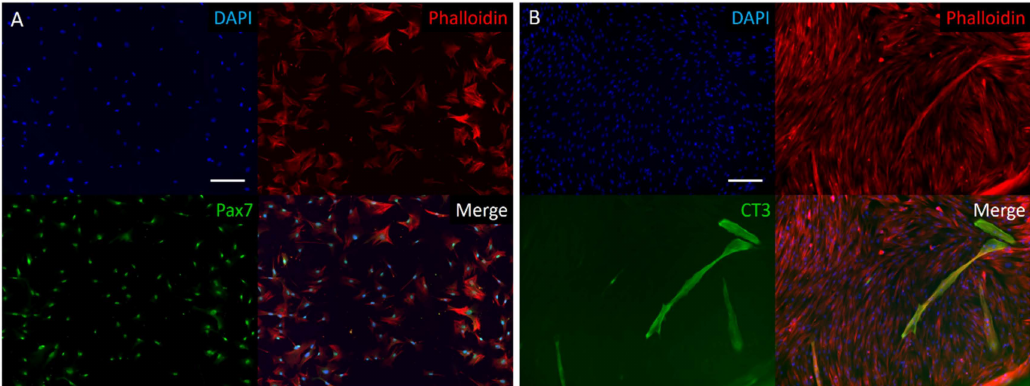
Figure 1. Two-dimensional immunofluorescence stain of isolated bovine muscle satellite cells (BSCs). ( A ) Proliferating bovine satellite stained for DAPI, actin cytoskeleton (Phalloidin), and Pax7, a nuclear marker of satellite cells. Stains show a highly pure satellite cell population, following isolation and pre-plating protocol. ( B ) Following one week of di ff erentiation, cells were stained for DAPI, actin cytoskeleton (Phalloidin), and Troponin T (CT3), a marker of myogenesis. Scale bars are 200 µ